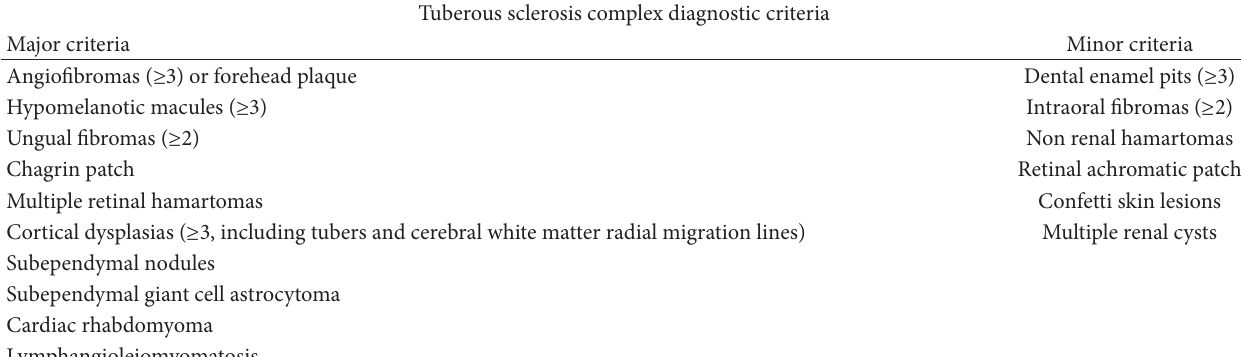
Table 1: Major and minor diagnostic criteria for tuberous sclerosis complex [3].